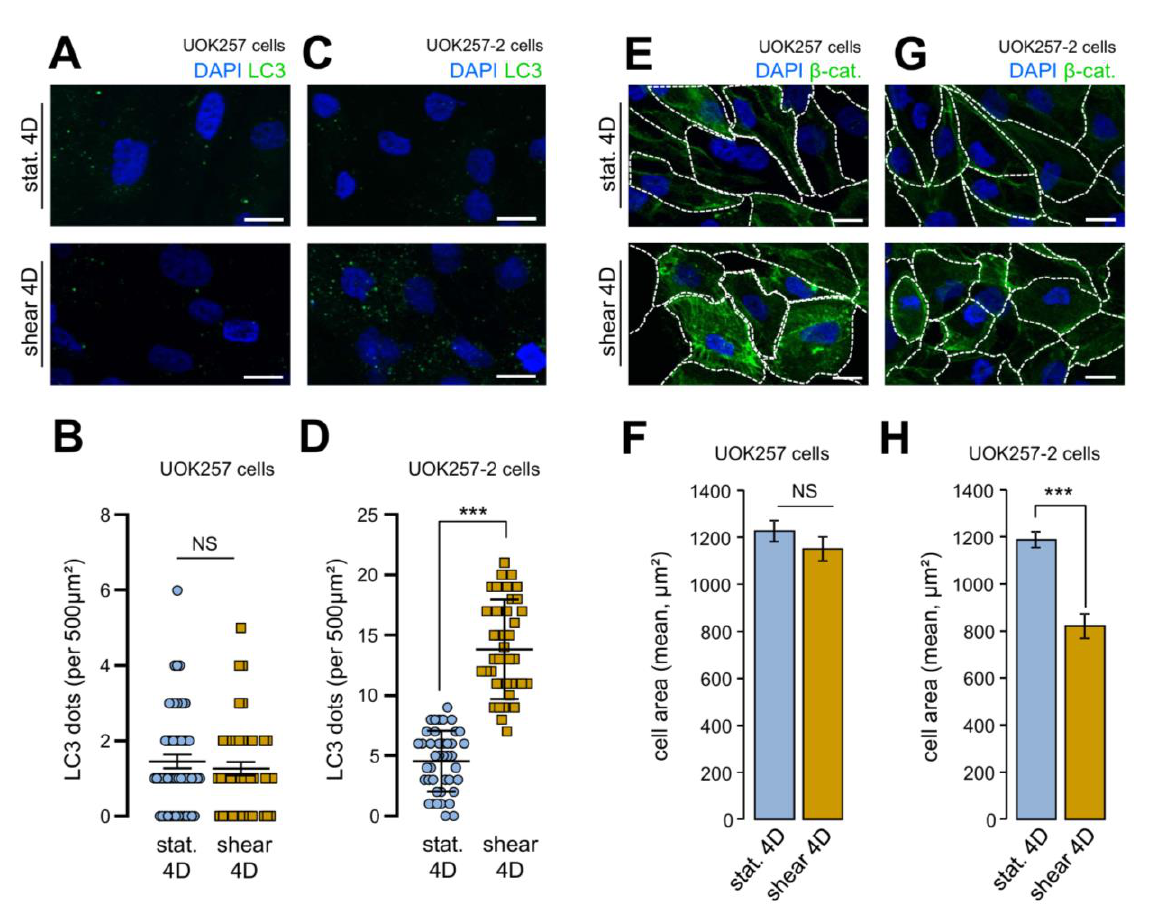
FIGURE 5: Shear-stress-induced autophagy and cell size regulation are abolished in FLCN-null cells. UOK 257 FLCN-null cells and UOK 257- 2 FLCN restored cells were cultured on microslides and then subjected to fluid flow for 4 days (shear) or not (static 4D). Cells were fixed, labeled with DAPI, immunostained for LC3 (A, C) or l abeled with DAPI and immunostained for β -catenin to reveal cell boarder (E, G) and then analyzed by fluorescence microscopy. (B, D) LC3 dots were quantified from experiments shown in (A) (UOK 257cells) and (C) (UOK 257-2 cells). (F, H) cells areas were quantified from experiments shown in (E) (UOK 257cells) and (G) (UOK 257-2 cells). Scale bars in (A, C, E and F) =